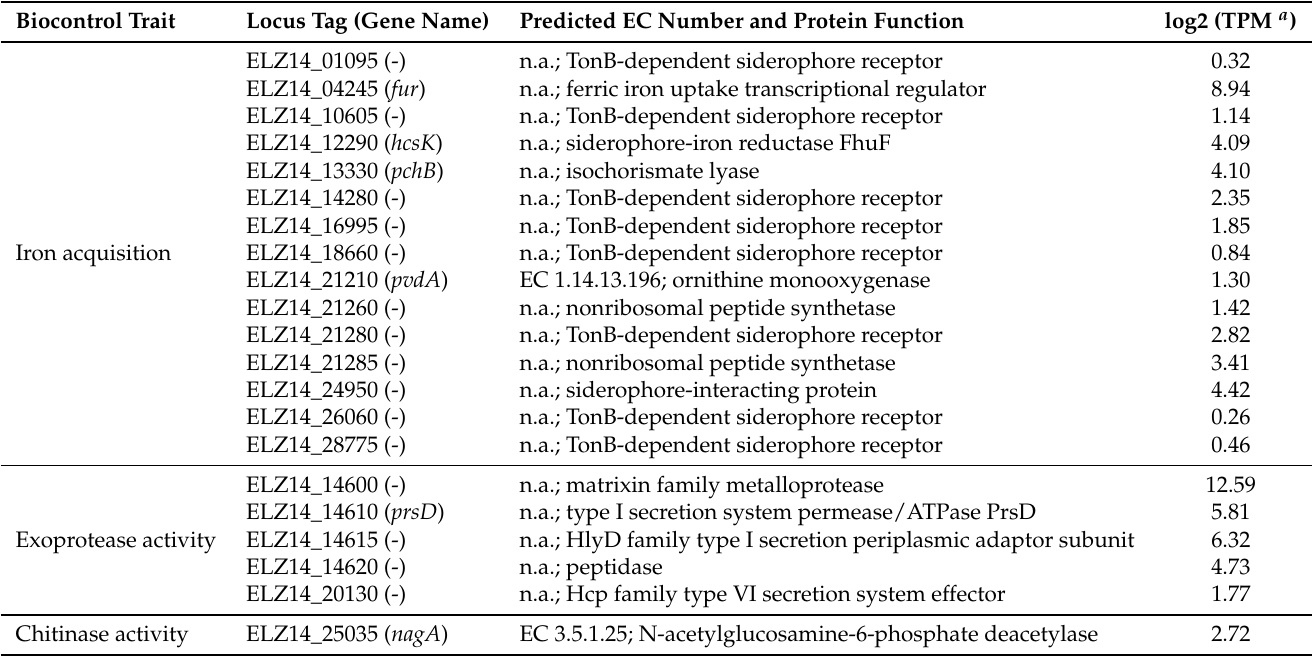
Table 7. Genetic biocontrol determinants of P. brassicacearum 3Re2-7 - Pathogen